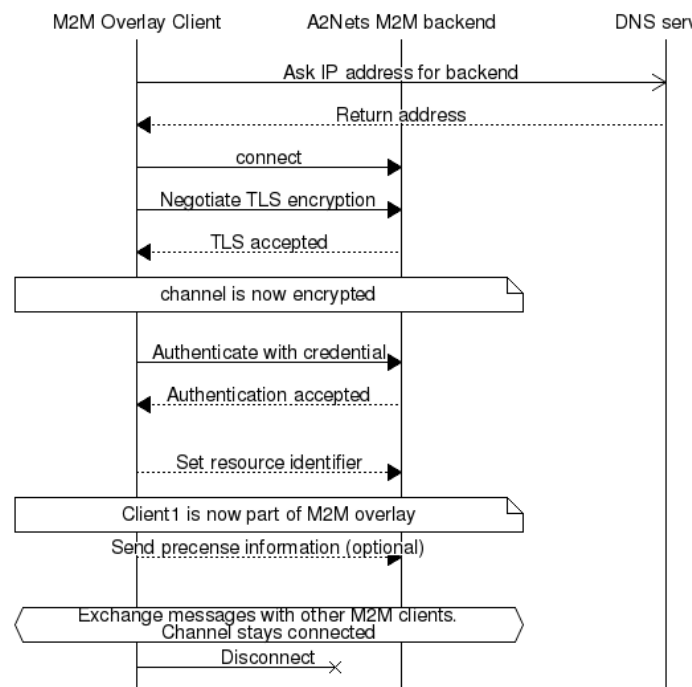
Figure 10. M2M client connecting to XMPP